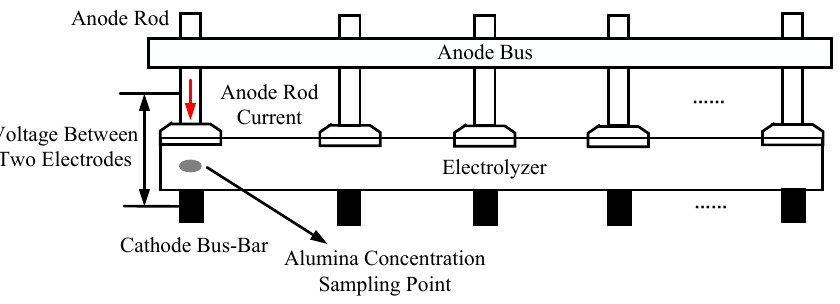
Figure 4. Schematic diagram of the variable collection system.